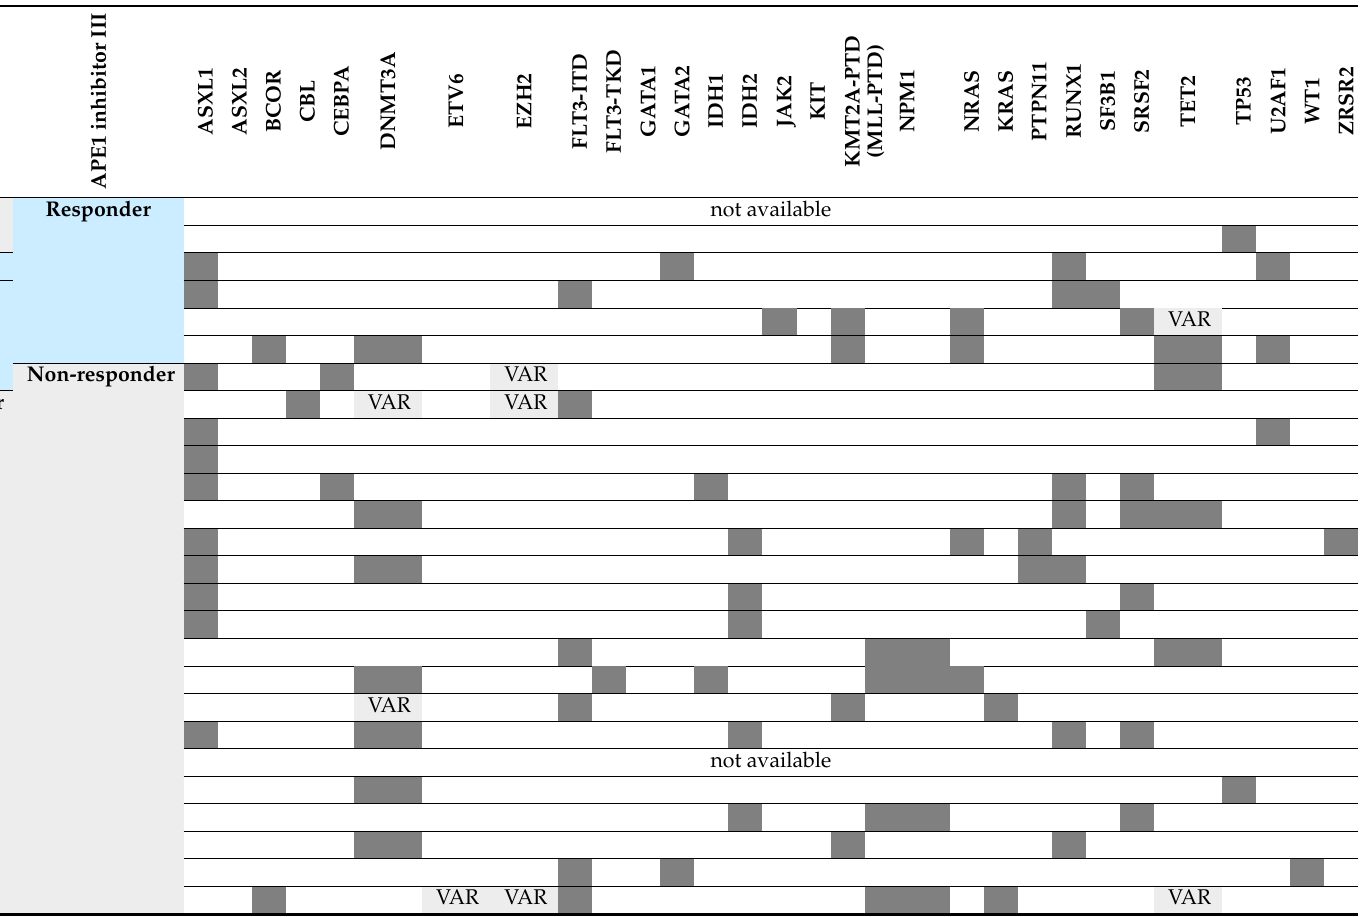
Table 3. Cytotoxic e ffi cacy of talazoparib and APE1 inhibitor III in myelodysplastic syndromes / chronic myelomonocytic leukemias and acute myeloid leukemias in relation to gene mutations. AML: acute myeloid leukemia; CMML: chronic myelomonocytic leukemia; MDS: myelodysplastic syndrome; VAR: